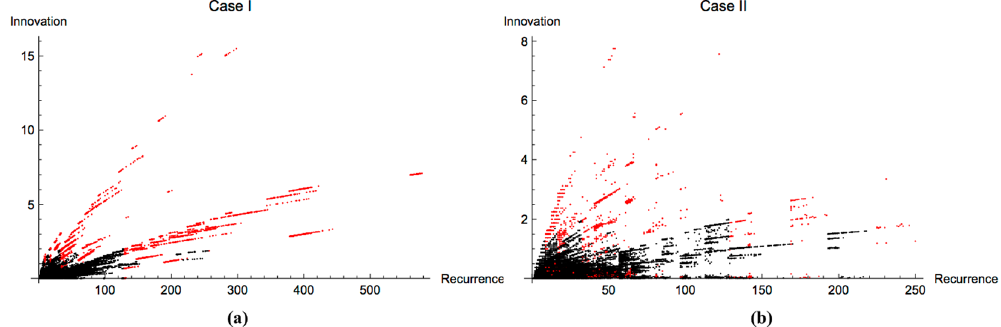
Figure 7. Relative innovation as a function of recurrence times for Case I (left) and Case II (right) CA. Highlighted in red are cases exhibiting OEE.